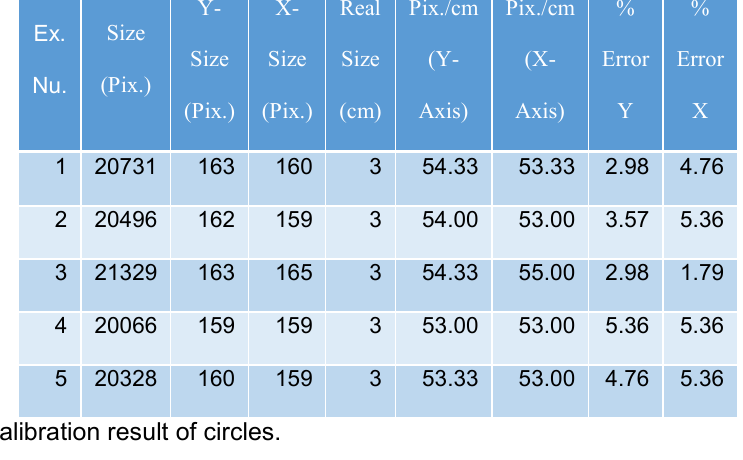
Table 1. The circle specification before calibration.